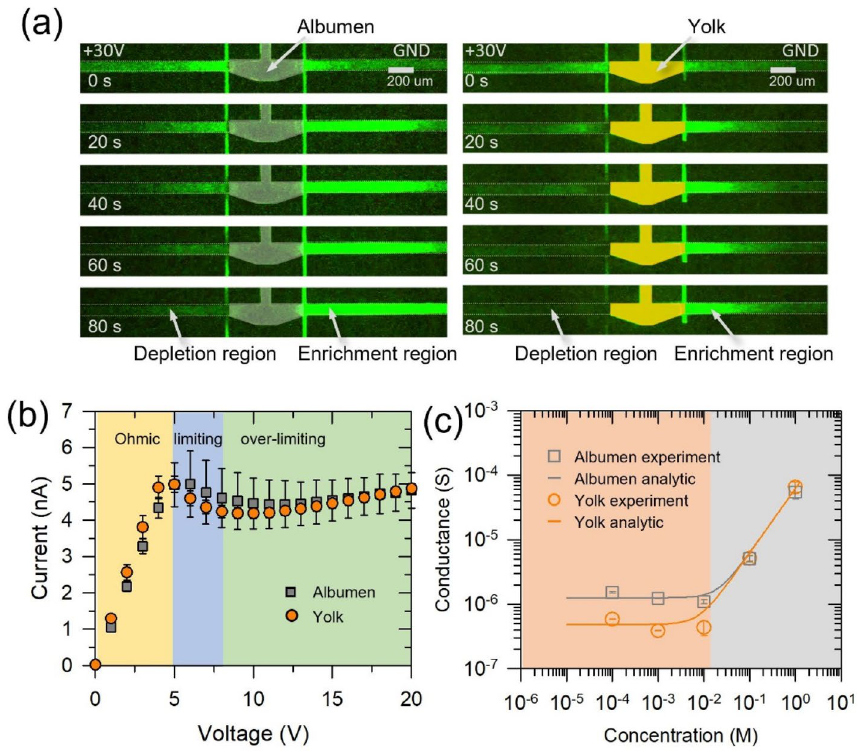
Figure 4. ( a ) The visualization of an ion depletion zone and an ion enrichment zone resulted from ICP phenomenon using egg devices. ( b ) I-V characteristics of egg devices. ( c ) Conductance profile of the egg devices. The error bars on the plots were standard